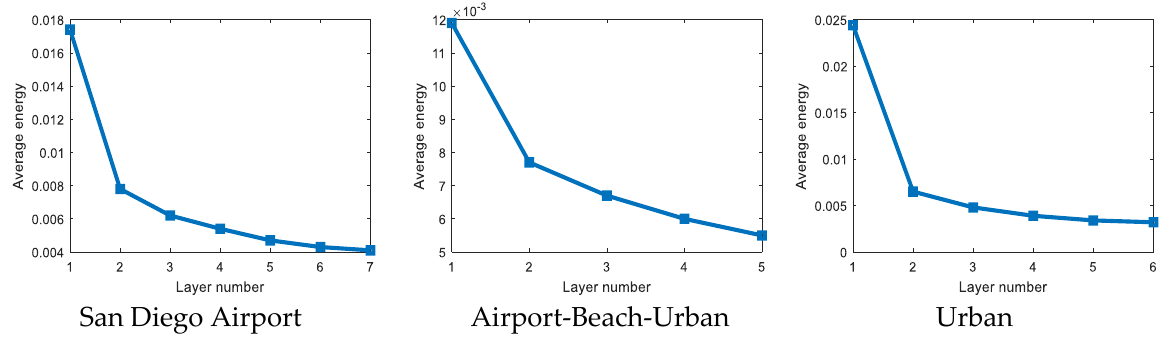
Figure 9. The average energy of HSMF with different layers on three hyperspectral data.